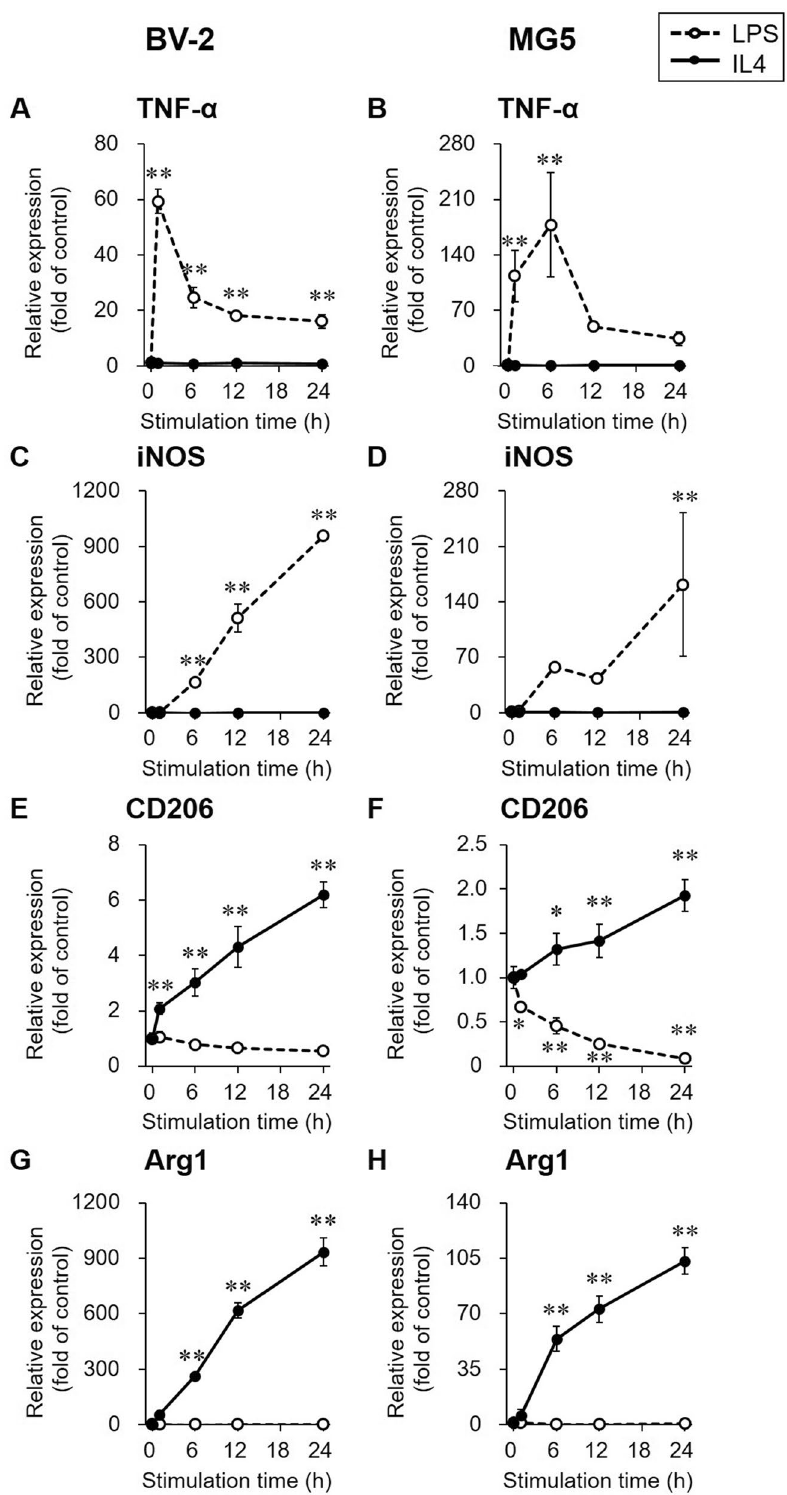
Figure 1. Gene expression of pro- and anti-inflammatory markers. Relative gene expression levels of the proinflammatory markers tumor necrosis factor-α (TNF-α, A and B ) and inducible nitric oxide synthase (iNOS, C and D ) and the anti-inflammatory marker genes CD206 ( E and F ) and arginase 1 (Arg1, G and H ) were determined by RT-PCR in LPS (1000 ng/mL, open circle and dashed line)- or IL4 (60 ng/mL, closed circle and solid line)-stimulated BV-2 and MG5 cells. The results are presented as the fold change in expression relative to the control group (0 h stimulation) and the means ± SDs of three samples. Statistical differences were analyzed by ANOVA followed by Dunnett’s multiple comparison test; * p < 0.05, ** p < 0.01 compared with the